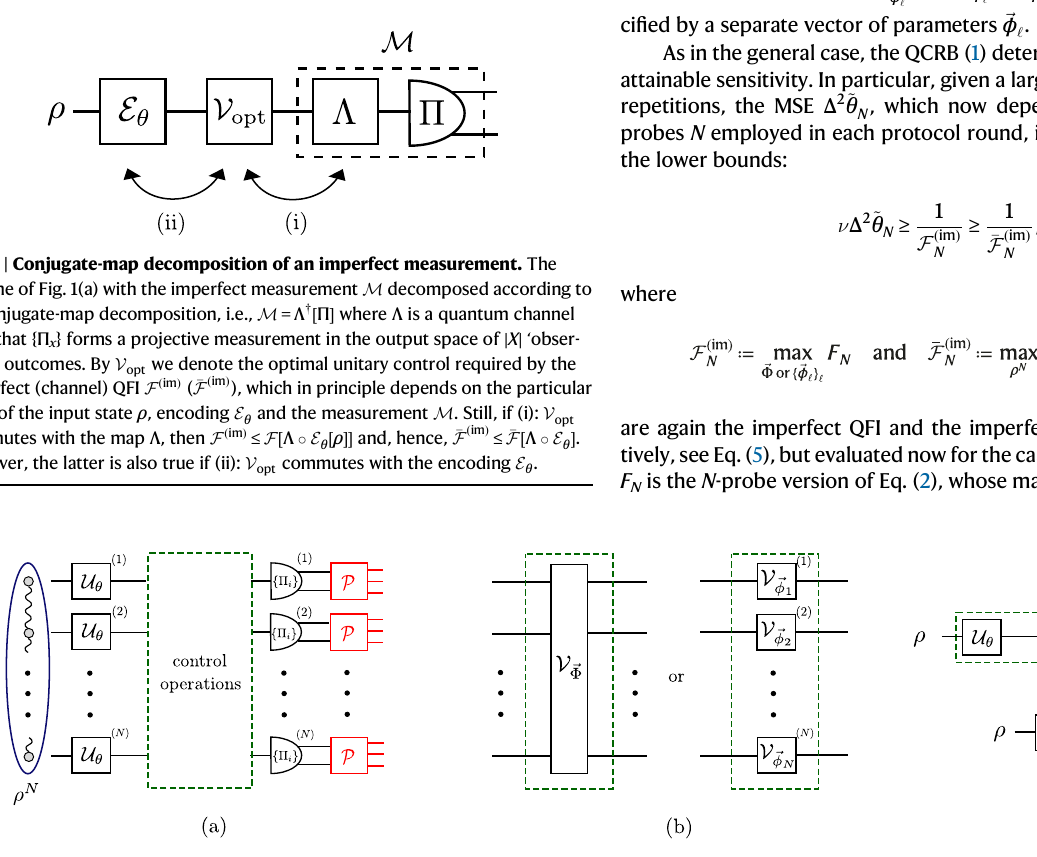
Fig.4|Multi-probescenariossupplementedbycontroloperations.a Canonical multi-probe scenario of quantum metrology with imperfect measurements. N